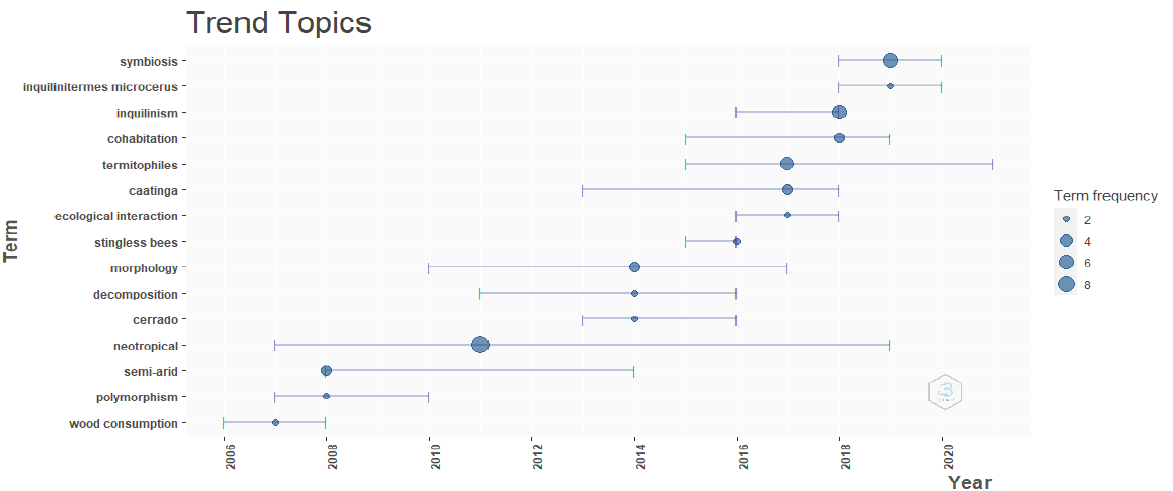
Figure 4. Trend topics observed in keywords of the 54 works about Constrictotermes cyphergaster utilized in present study. The plot shows the frequency of terms (dots) over years and in which years terms were present (whiskers).